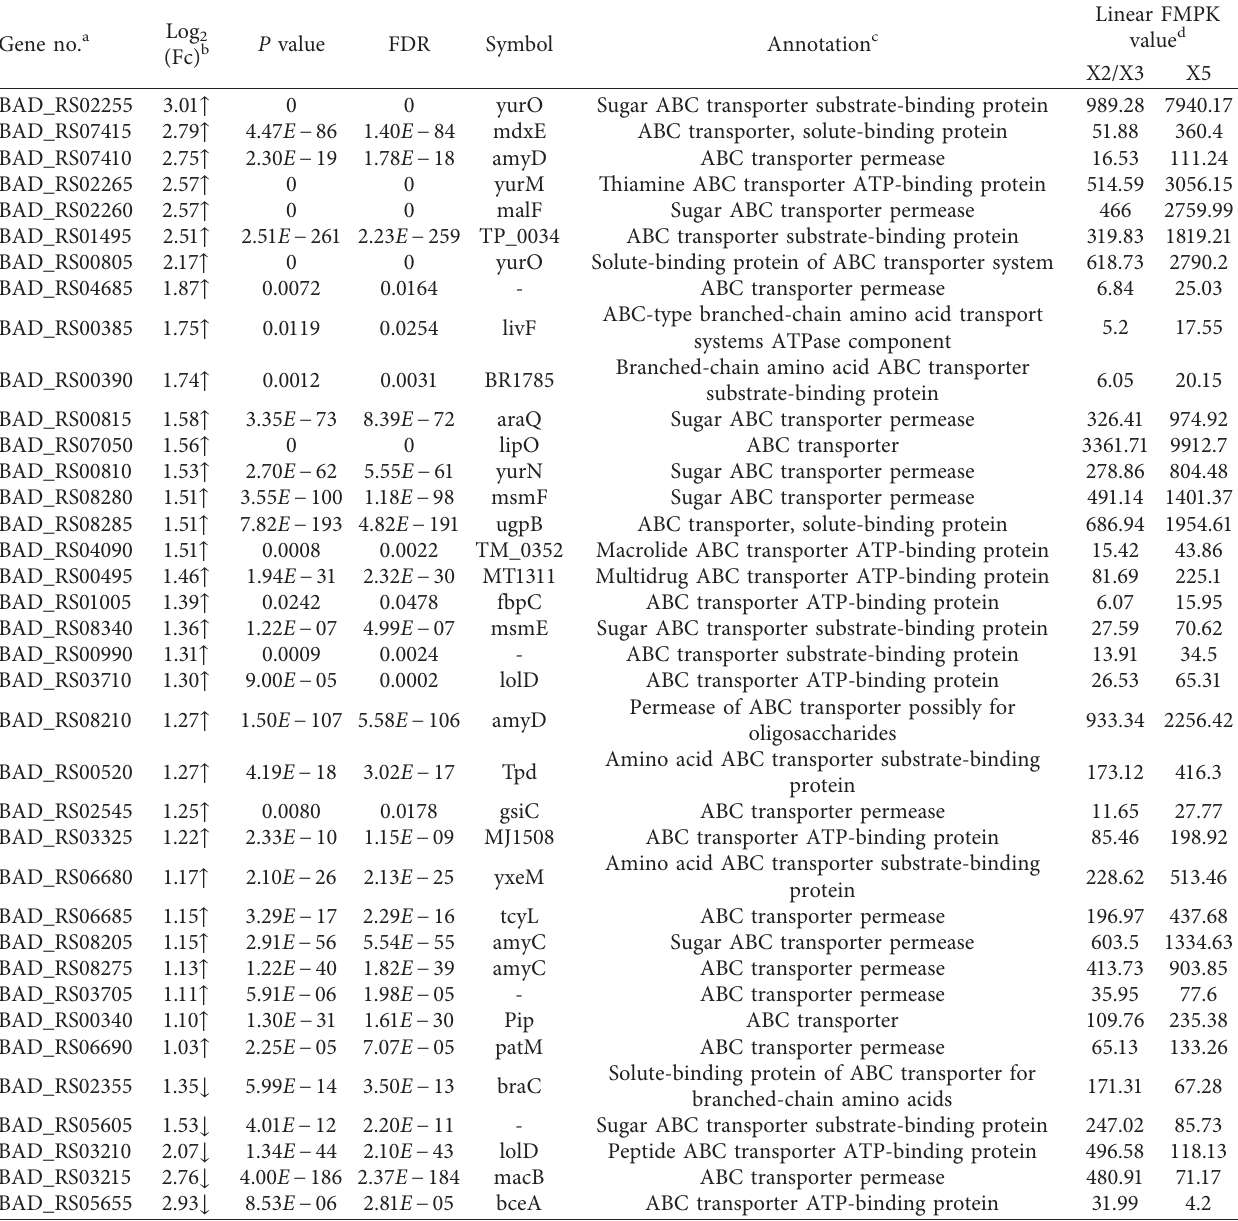
Table 1: DEGs involved in the related ABC transporter during the growth of B. adolescentis on X5 compared to X2/X3 assessed by RNA-seq. Gene no.